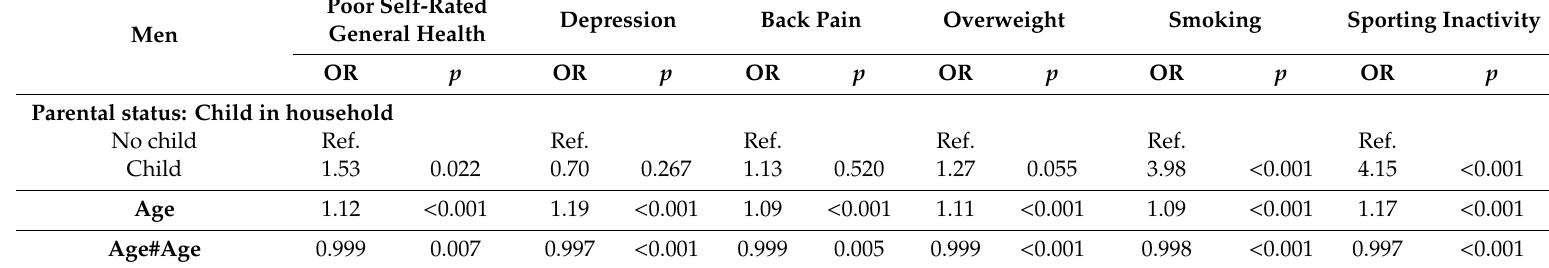
Table 4. Results of the logistic regressions with interaction of parental status and age for men (odds ratios, p values; age (metric) centered at the minimum of 18 years). Poor Self-Rated Depression Back Pain Overweight Smoking Sporting General Health Men